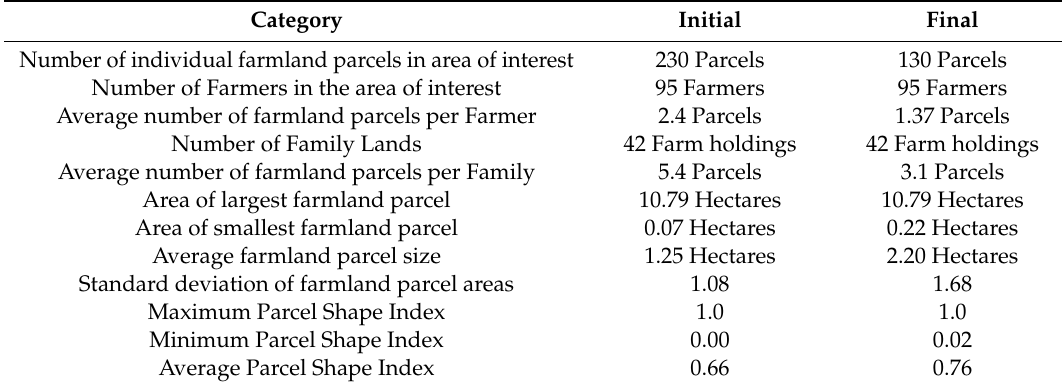
Table 1. Summary of the e ff ect of the approach of the land reallocation. Category Initial Number of individual farmland parcels in area of